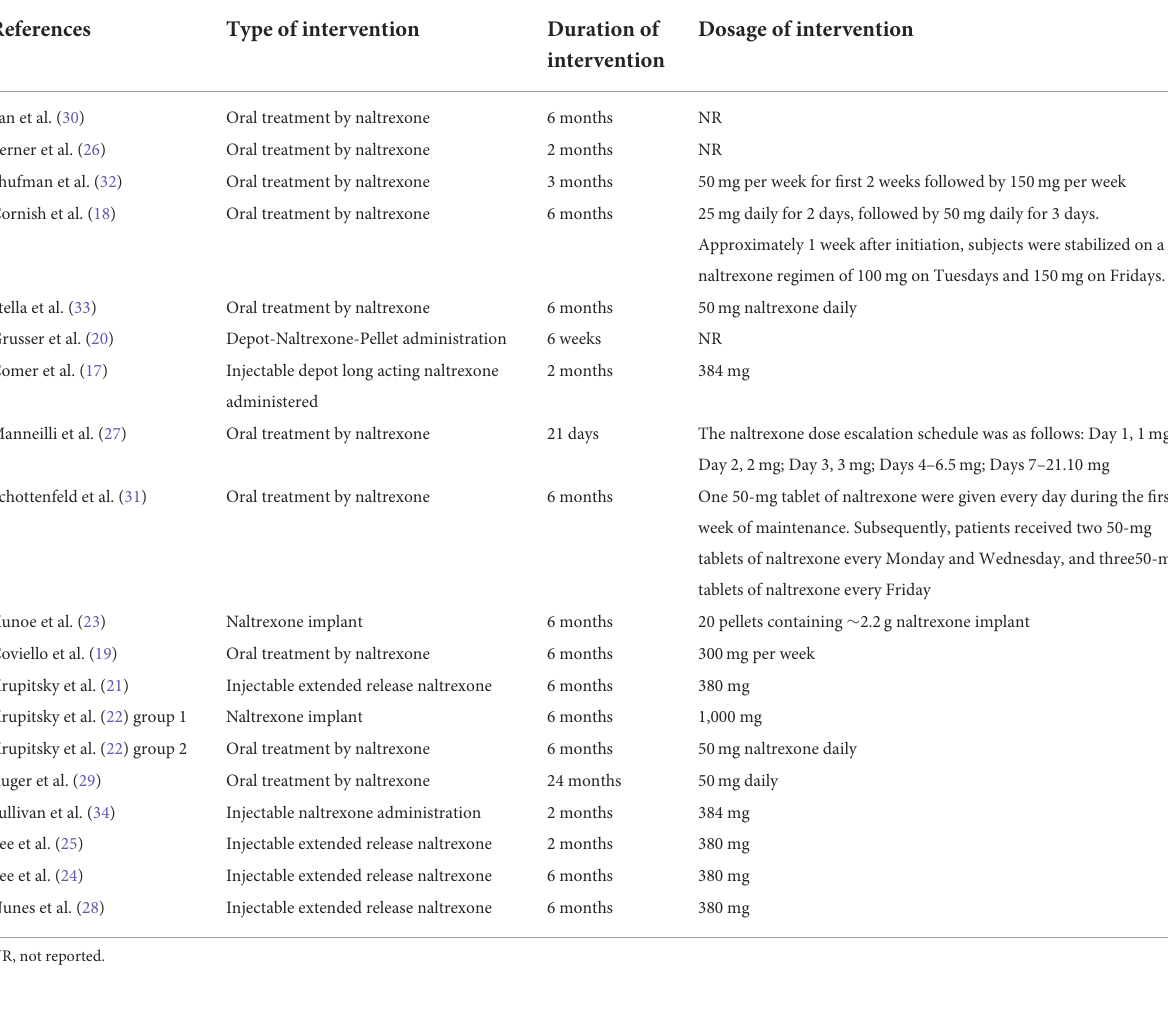
TABLE 3 Intervention characteristics.